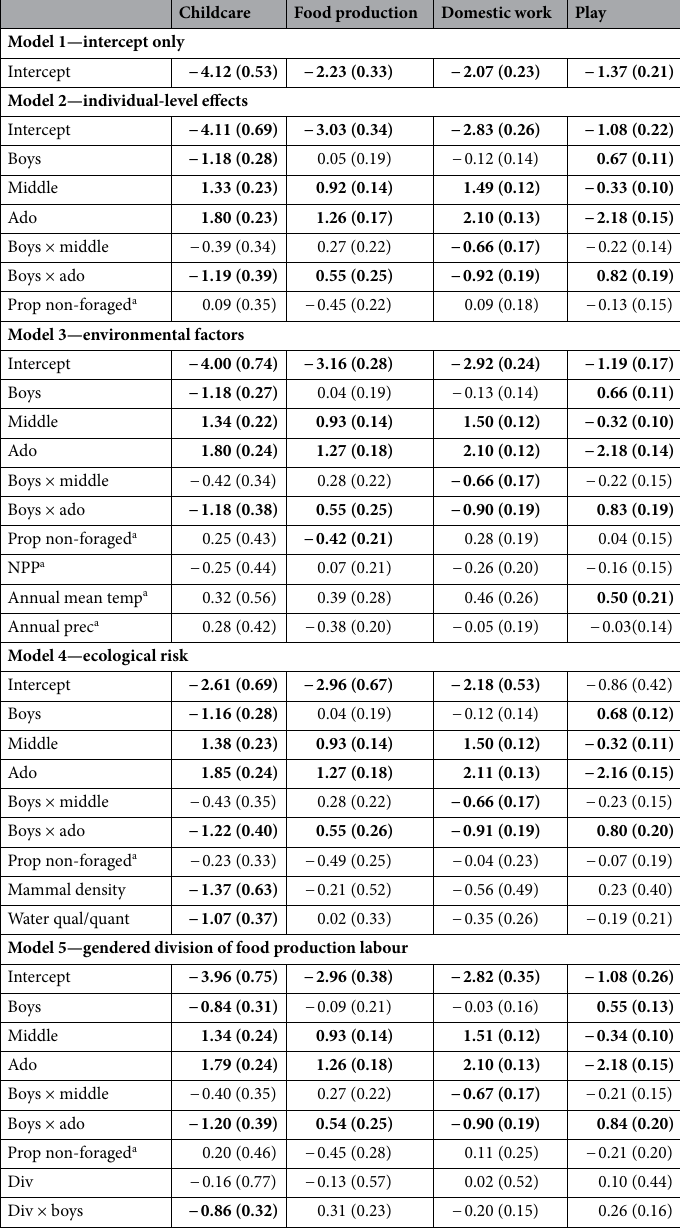
Table 3. Posterior means of fixed effects for models 1–5. Standard deviations are in parentheses. Parameters in bold represent estimates whose 95% credible intervals do not cross zero. Boys 1 = boys, 0 = girls. Middle 1 = Middle Childhood (between 7 and 12 years of age, late juveniles for the Mikea dataset), 0 = Early Childhood (between 3 and 6 years of age, early juveniles for the Mikea dataset). Ado 1 = Adolescence (between 13 and 18 years of age, young adults for the Mikea dataset). Propnon-foraged Proportion of domesticated foods and foods purchased and/or traded. NPP Net Primary Productivity in gC/m 2 /year. Annual mean temp Annual Mean Temperature, in °C. Annual prec Annual Precipitation, in mm. Mammal density Density of Dangerous Mammals, Low/High. Water qual/quant Water Quality/Quantity, four-point scale. Div Gendered Division of Food Production Labour, standardized to between − 2, women do all the food production labour and 2, men do all the food production labour. a These values were z -score